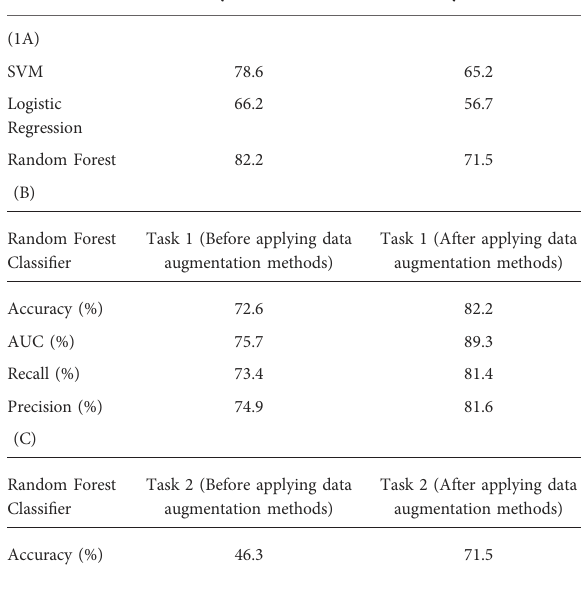
TABLE 1 ( A ) classi fi cation accuracy for AD/CN and AD stages/CN models after applying acoustic features and data